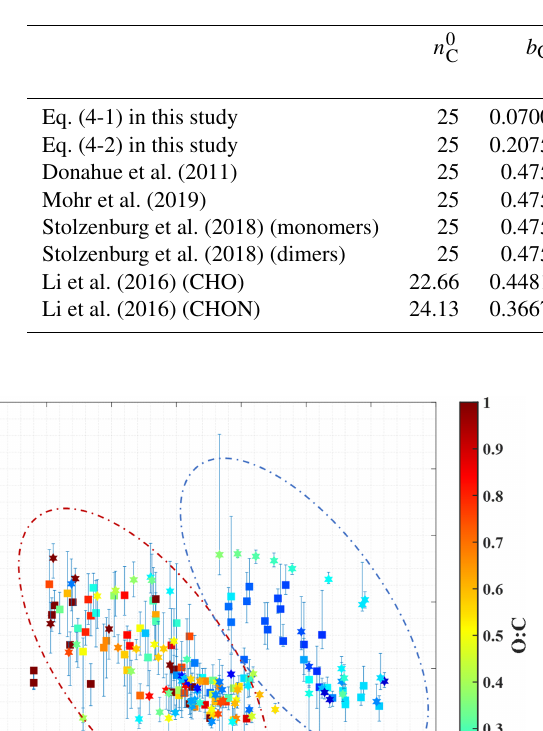
Table 2. The volatility parameterizations of this study and cited literature. In this study, the parameterizations of saturation mass concentration were modified by the least-squares optimization from Eq. (4) at 298K.